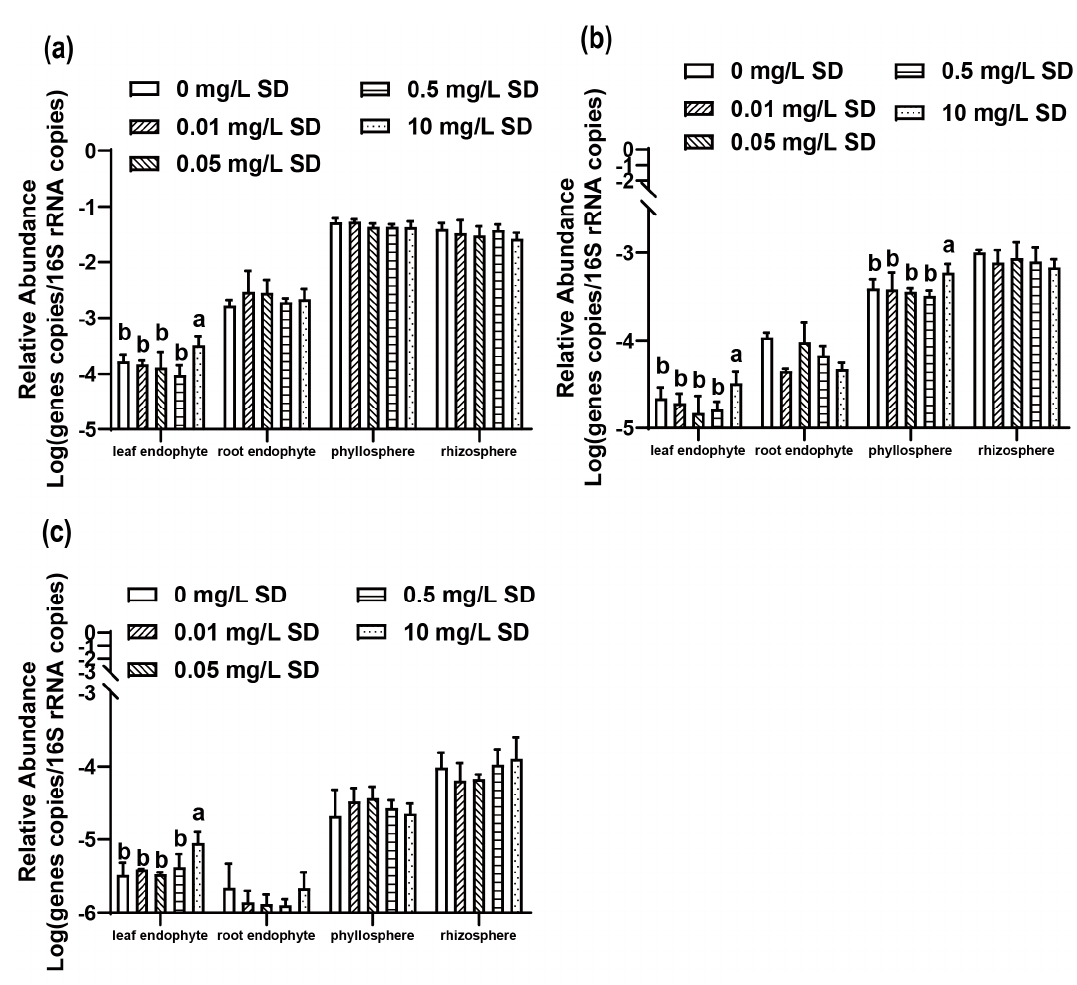
Figure 4. Effects of SD concentration on the relative abundance of antibiotic resistance genes ( sul 1, sul 2) and tnpA in different parts of lettuce. Error bars represent standard deviations of the means. a and b on top of the error bars represent significant differences ( p < 0.05) among different initial concentrations of treatments. ( a ) sul 1; ( b ) sul 2; ( c ) tnpA .